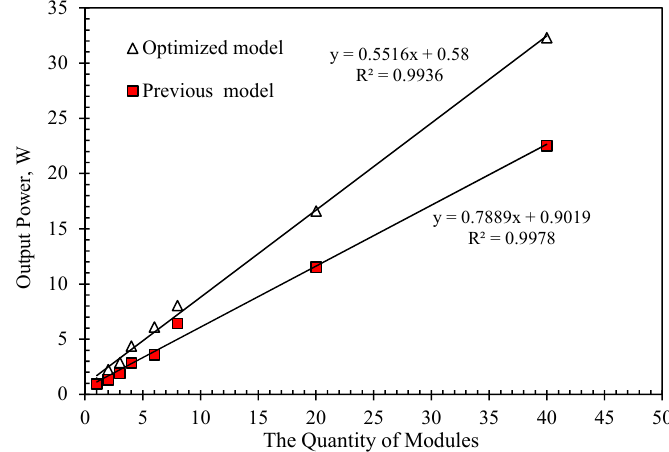
Figure 16. Maximum output power of the optimized model and previous model at different ∆ T.